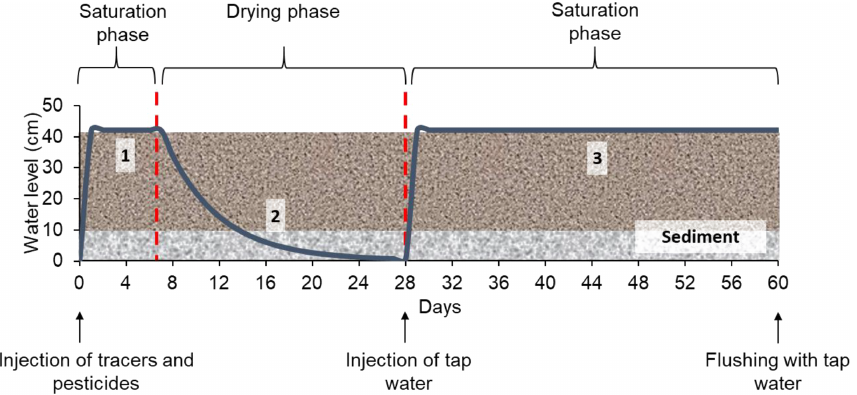
Figure 2. Experimental protocol with the different phases and injections performed during the experiment. The x axis indicates the duration of the experiment, and the y axis indicates the variation of the water level during the different phases. The water level curve (blue) is only schematic and does not correspond to real water level